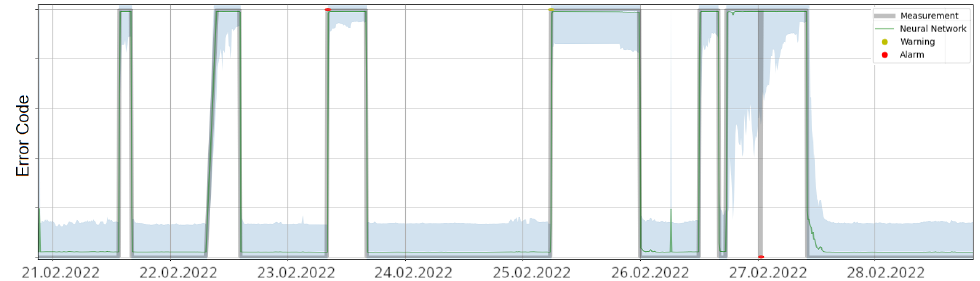
Figure 9. The direct modelling of the error codes leads to a model that can predict the gearbox failures very well as they happen but not in advance. This can be seen by the DNN (green line) following the error code (grey line) closely.